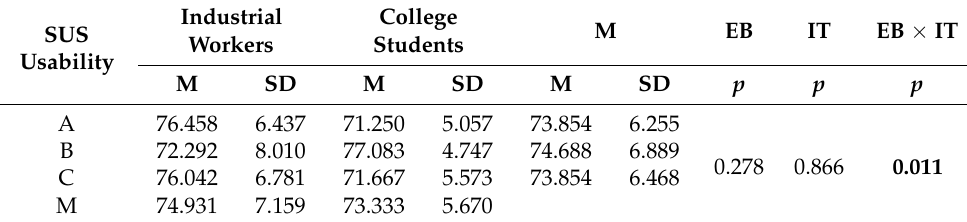
Table 4. Descriptive statistics and two-way ANOVA of SUS usability.